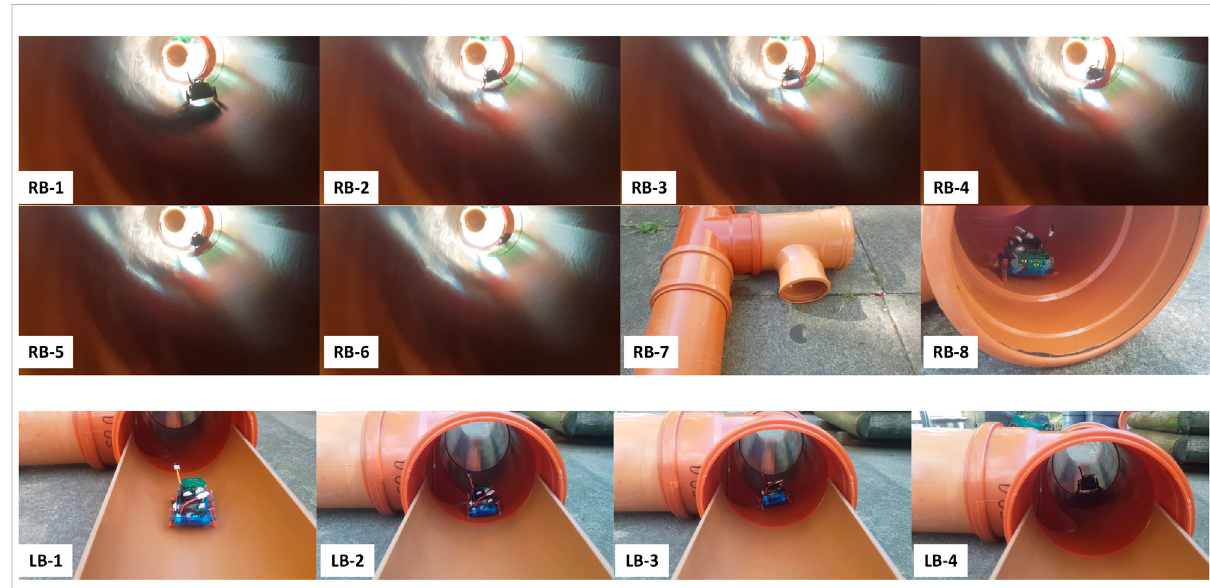
FIGURE 7 Decisions and maneuvers of the Joey robot at right and left branches during autonomous exhaustive exploration. The top two rows show in sequence (RB-1 to RB-8) images of Joey approaching and then turning into a right branch. The bottom row shows in sequence (LB-1 to LB-4) the captured images ofJoeyapproaching but notturning into aleftbranch. Therobot continues straight atleftbranch, inagreement with thehigh-level rule of taking the rightmost